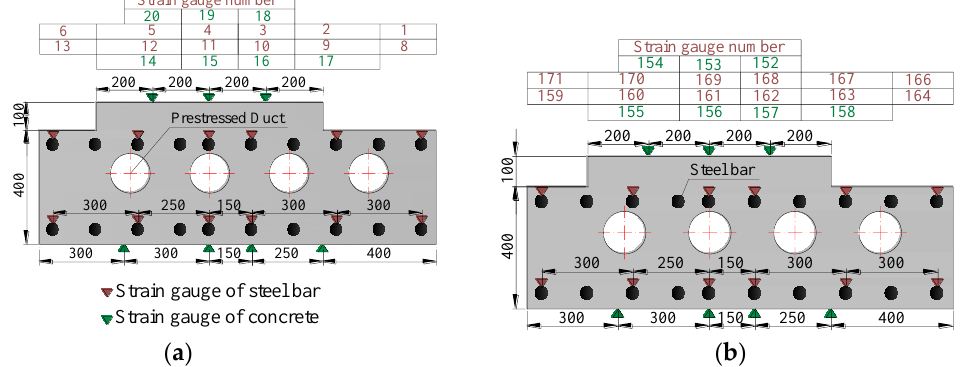
Figure 9. The arrangement of the strain gauges on the top slab specimen (unit: mm): ( a ) Section A-A; and ( b ) Section I-I.